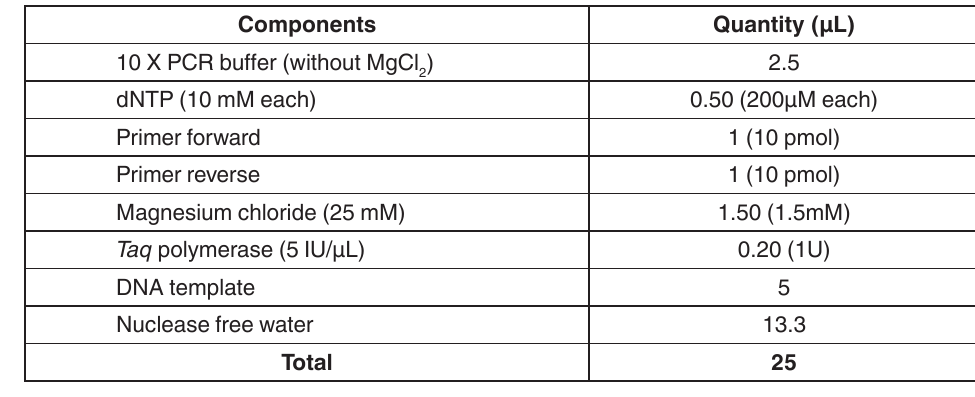
Table 1. Composition of reaction